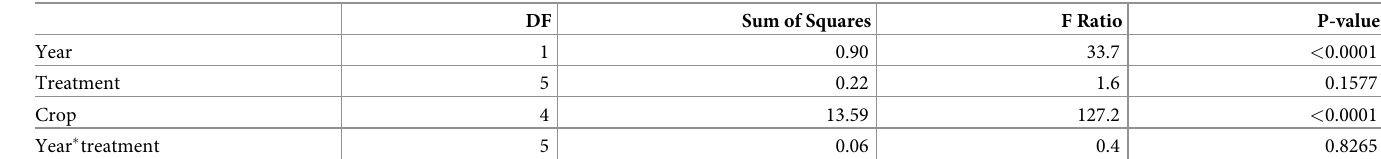
Table 2. Results of 3-way analysis of variance modeling log(yield) as a function of treatment, crop, year, and treatment � year interaction. R 2 = 0.69. DF Sum of Squares